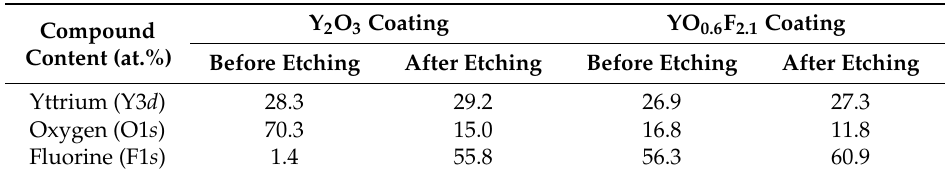
Figure 3. Mass loss owing to NF 3 plasma etching: Y 2 O 3 and YO 0.6 F 2.1 coatings. Table 1. XPS analysis results of Y 2 O 3 and YO 0.6 F 2.1 coatings before and after exposure to the NF 3